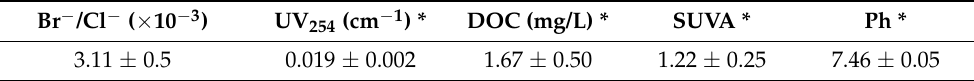
Table 2. Br − to Cl − ratios by weight and water quality parameters for bromine-spiked feed water (n =